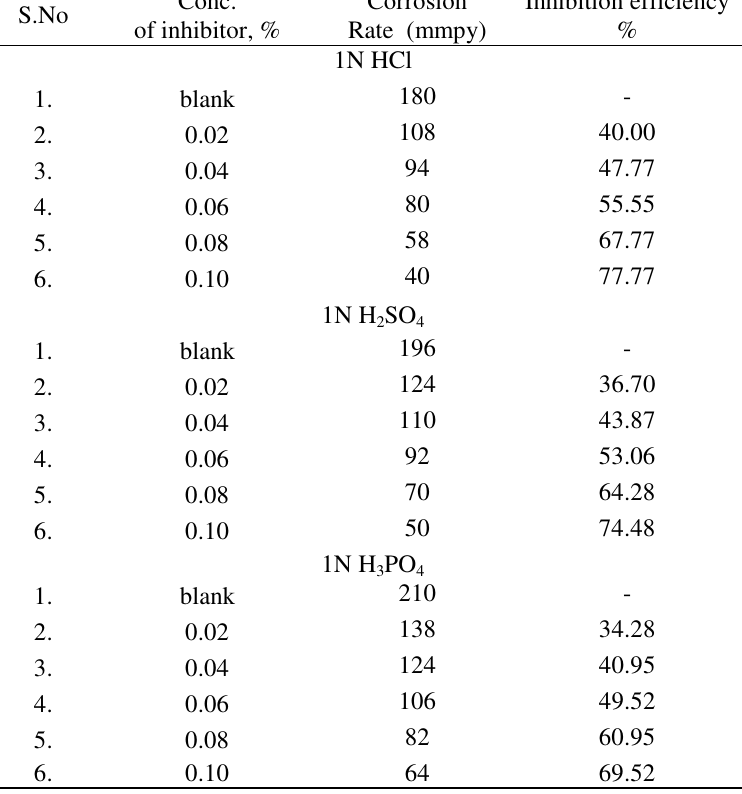
Table 1. Comparison table of different acids using AV extract at (1 h) S.No